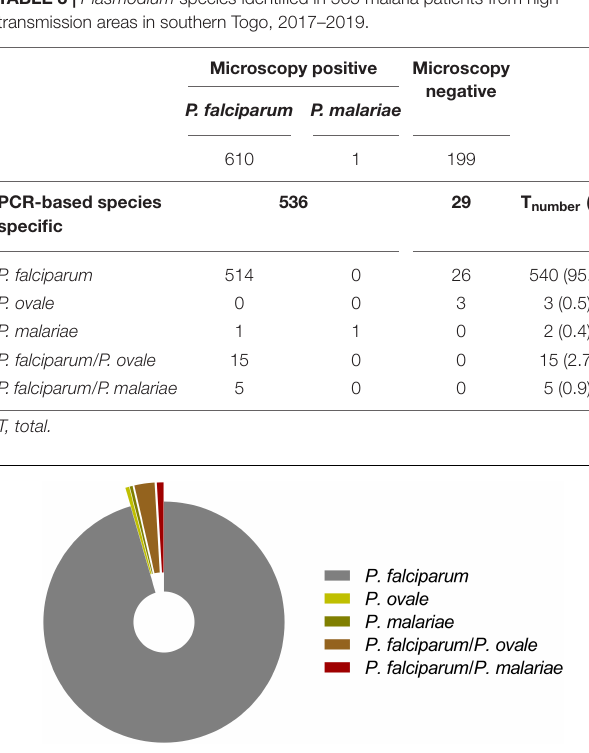
FIGURE 2 | Distribution of Plasmodium species identified in 565 malaria infections from high-transmission areas in southern Togo,